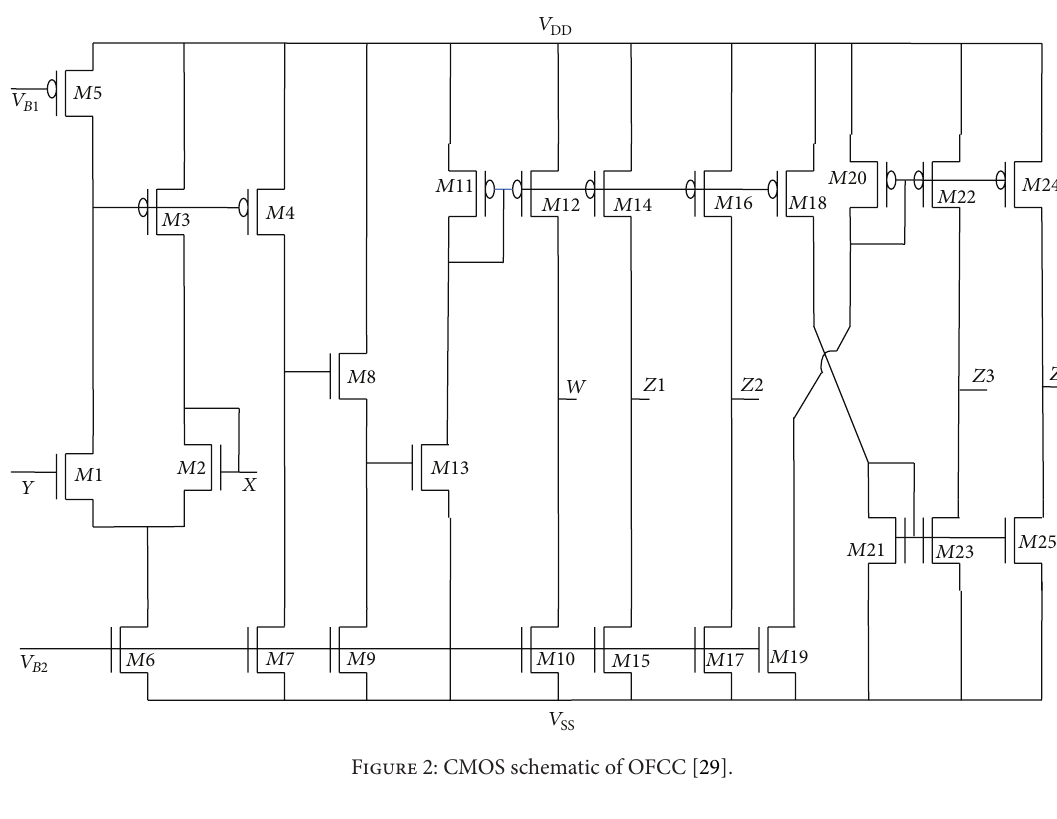
Figure 2: CMOS schematic of OFCC [29].